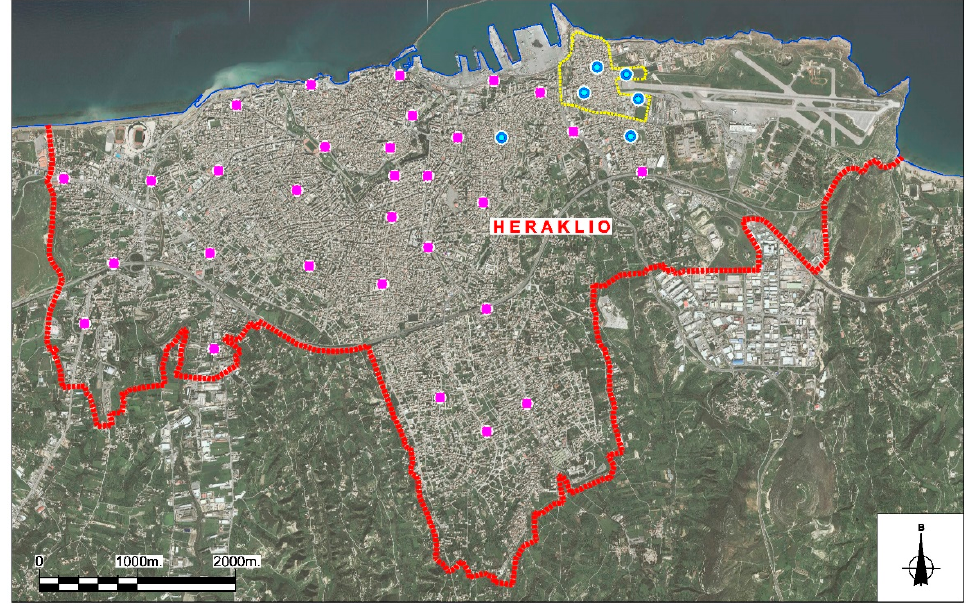
Figure 2. Geographical limits of the study subarea—Agglomeration of Heraklion (red dotted line)—Study area of Alikarnassos (yellow dotted line)—Positions of measurements for road traffic noise (magenta)—Positions of measurements for aircraft noise (blue).